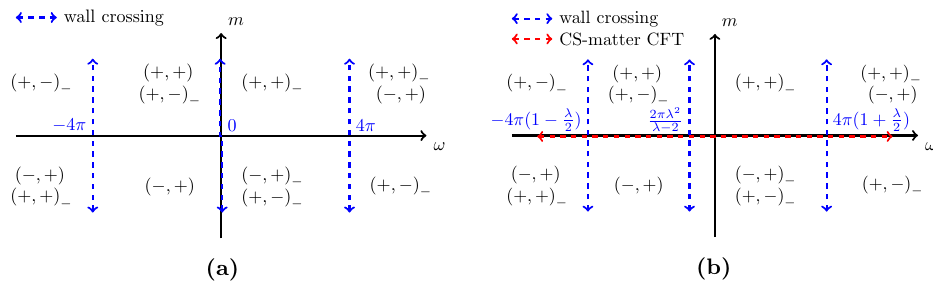
Figure 4. (a) Phase diagram at λ = 0 , which governs the “UV limit” κ → 0 . (b) Phase diagram of the IR theory studied by [3] at arbitrary λ ∈ [0 , 1] , governing the “IR limit” κ → ∞ .